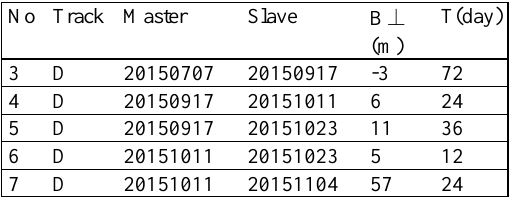
Table 1. Sentinel-1A/IW data used in this